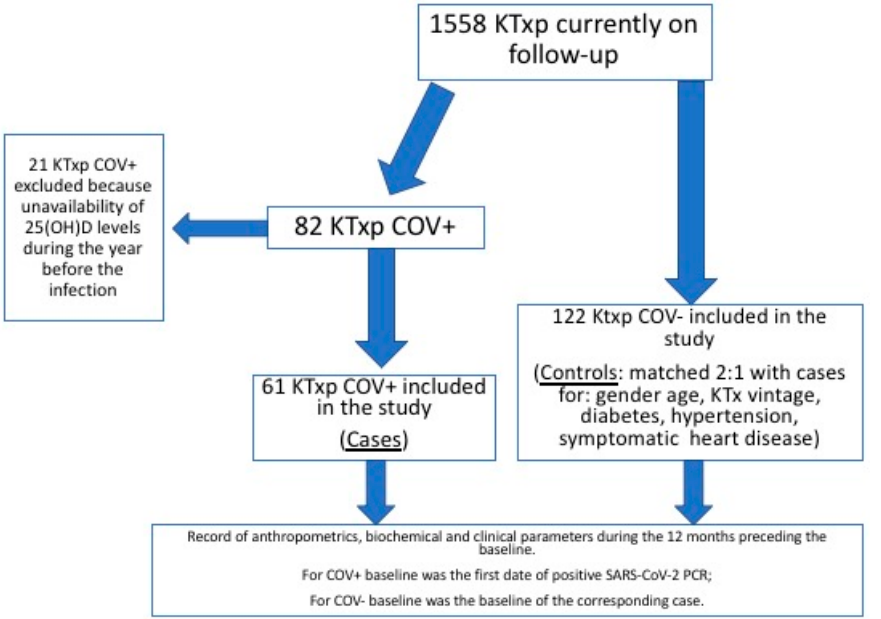
Figure 1. Flow-chart of the study. KTx, kidney transplantation; KTxp, kidney transplanted patients; COV+: KTxp with SARS-CoV-2 infection; COV − , KTxp without SARS-CoV-2 infection; 25(OH)D, 25-hydroxyvitamin D.